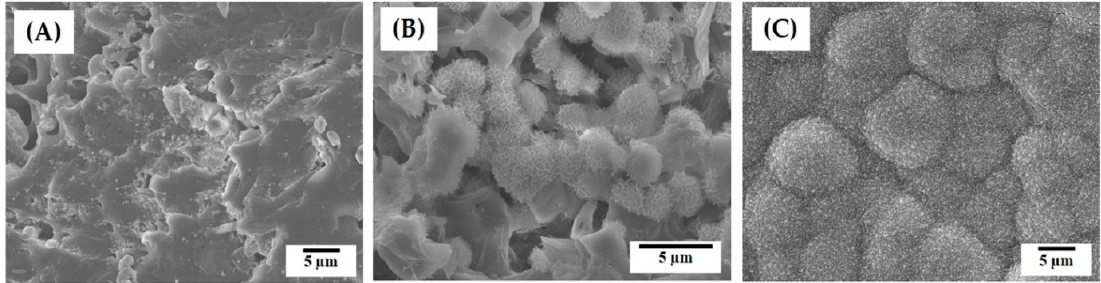
Figure 11. Representative FE-SEM images of the hierarchical macro/micro-porous PCL–CaP composite scaffolds produced with various HA contents after soaking in simulated body fluid (SBF) solution for 7 days: ( A ) 0 wt%, ( B ) 10 wt%, and ( C ) 20 wt%.